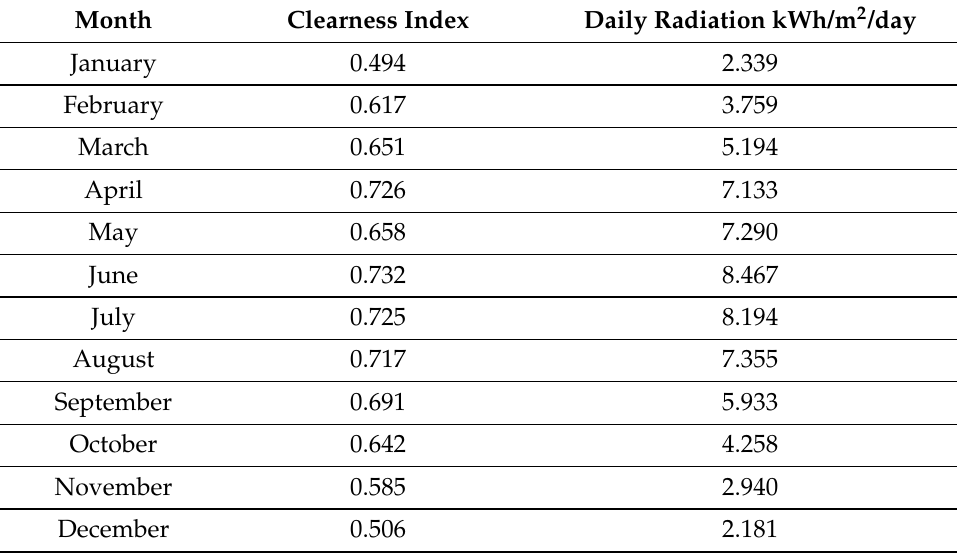
Table 2. Donoussa monthly average solar radiation data.